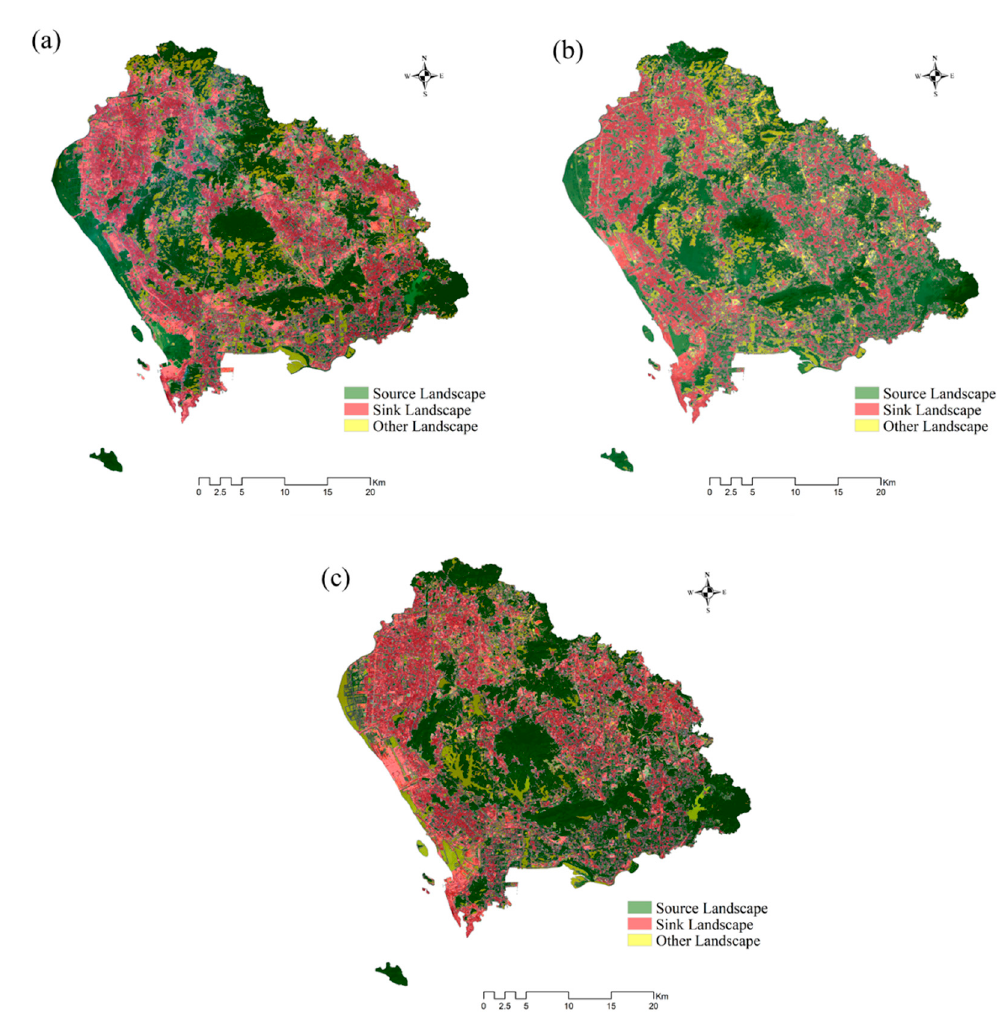
Figure 2. The distribution of source and sink landscapes in the western of Shenzhen in 2005 ( a ), 2010 ( b ), and 2013 ( c ) .